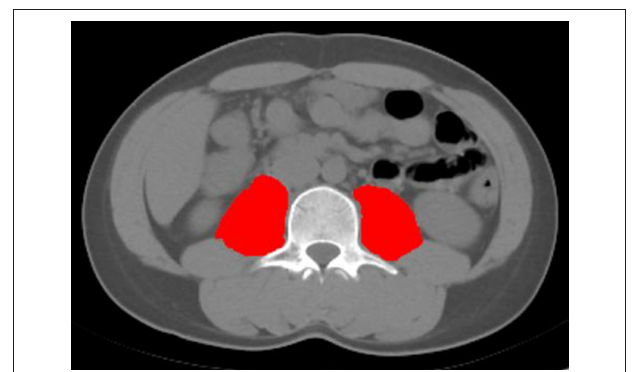
FIGURE 1 | The psoas muscle mass area at the level of L3